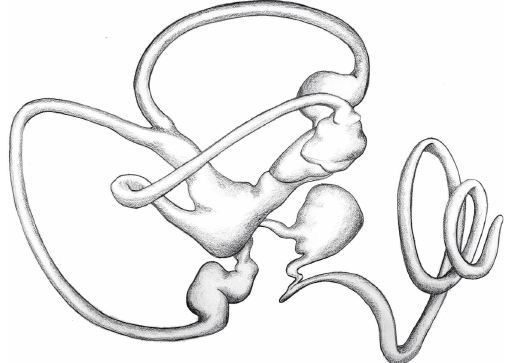
Figure 1: Artist’s depiction of a reconstructed human labyrinth.